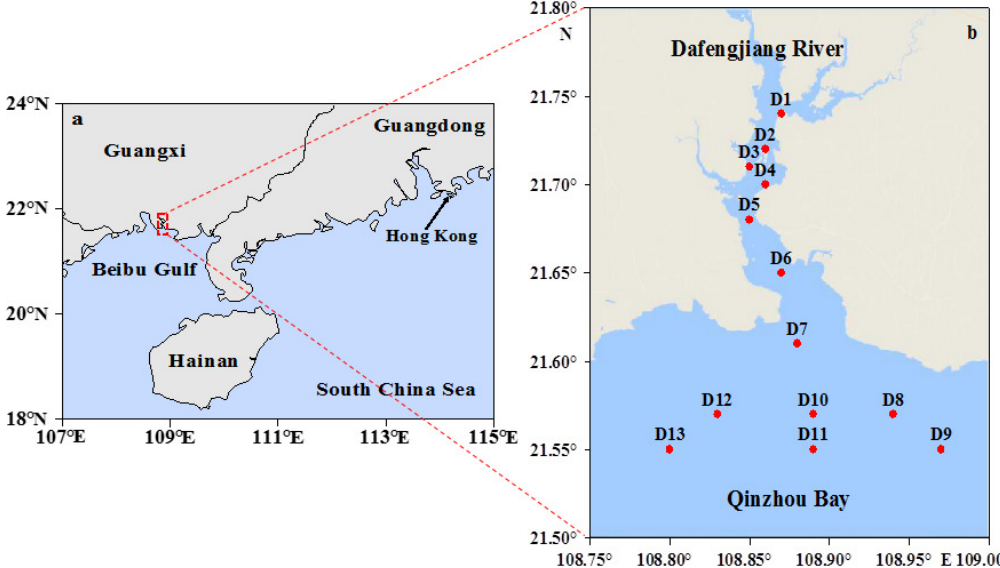
Figure 1. Map showing ( a ) the study station location and ( b ) sampling stations.